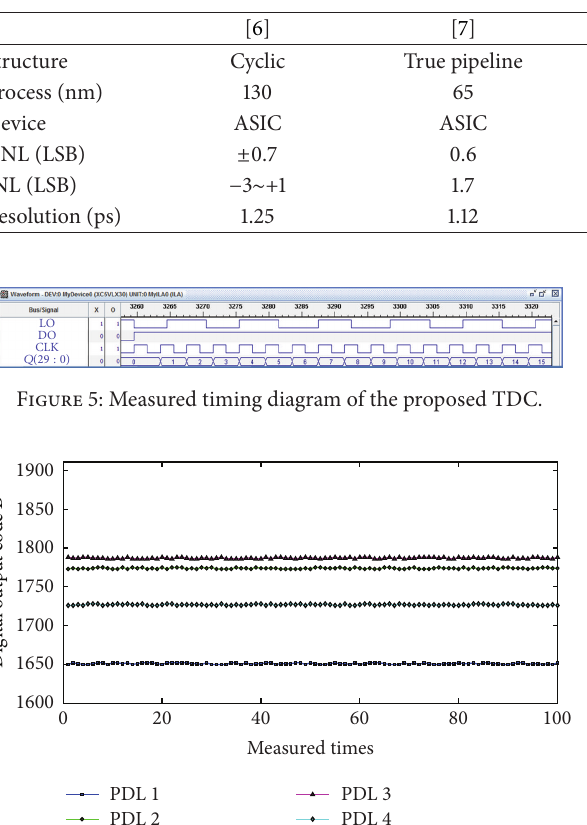
Table 3: Brief comparison with previous works.